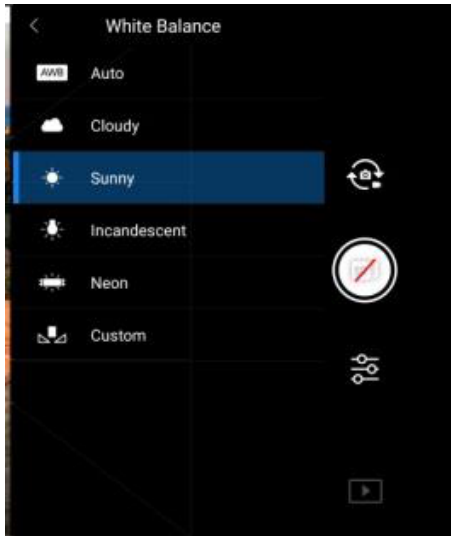
Figure 2 . White Balance was set to Sunny in DJI G04 app based on meteorological conditions at the time of the